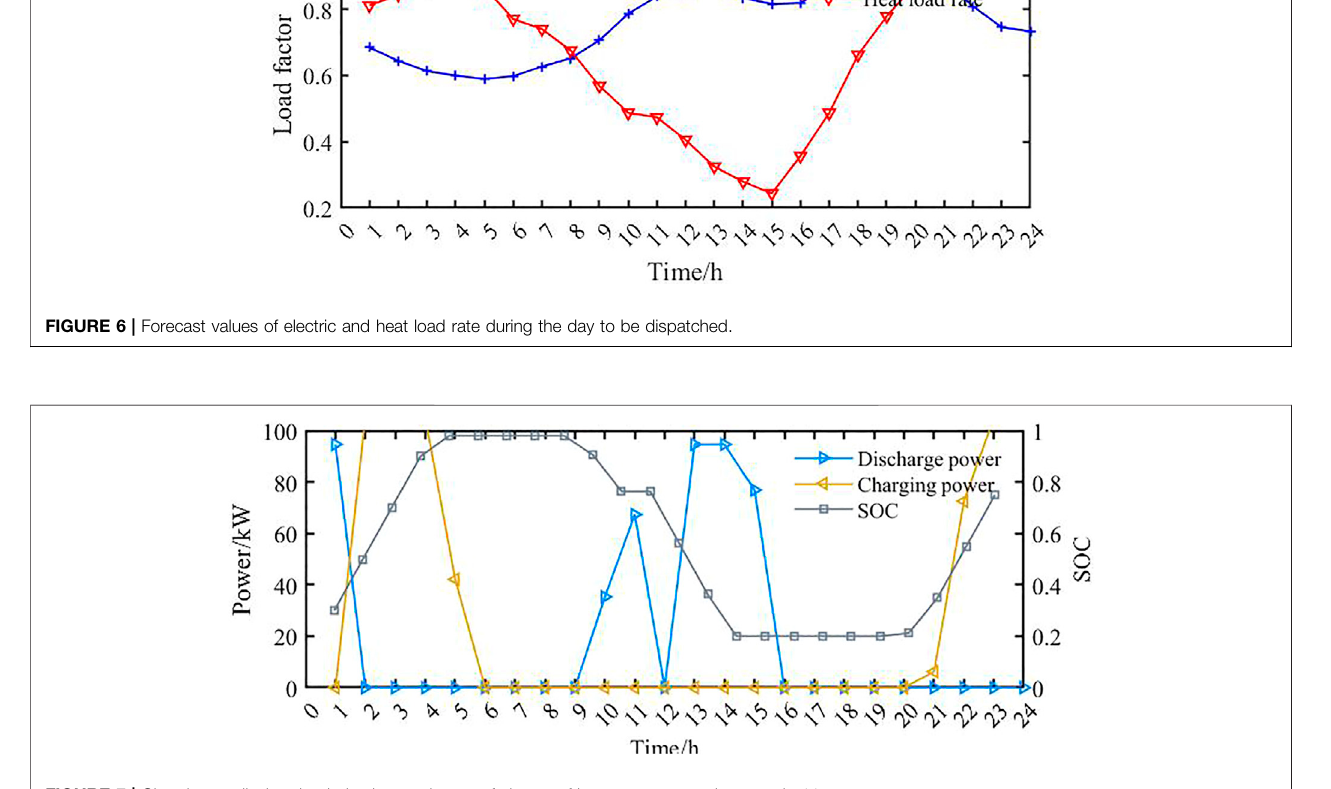
FIGURE 7 | Charging or discharging behaviors and state of charge of battery storage units at node 11.